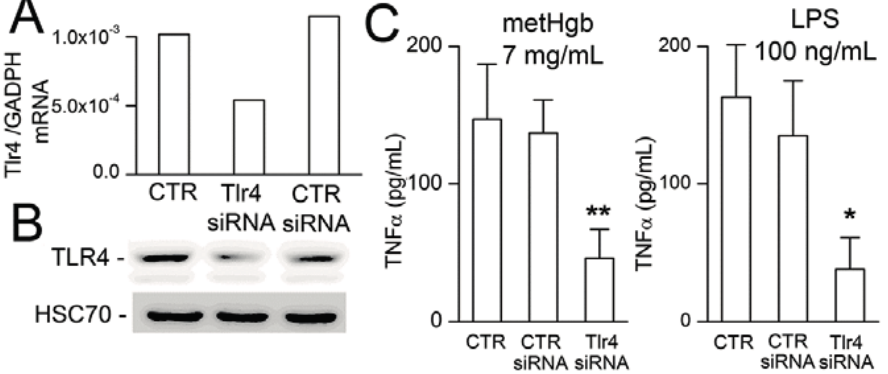
Figure 6. Suppression of Tlr4 reduces metHgb-induced TNF α secretion in microglia. ( A , B ) Tlr4 mRNA measured by qPCR ( A ) and TLR4 protein measured by immunoblot ( B ) under control conditions (CTR), and after transfection with control siRNA or siRNA directed against Tlr4 , as indicated; mRNA and protein from 5 wells pooled for analysis; ( C ) TNF α secretion induced by metHgb ( left panel) or LPS ( right panel) under control conditions or with siRNA suppression of Tlr4 , as indicated; 5 replicates per condition; * p < 0.05; ** p <